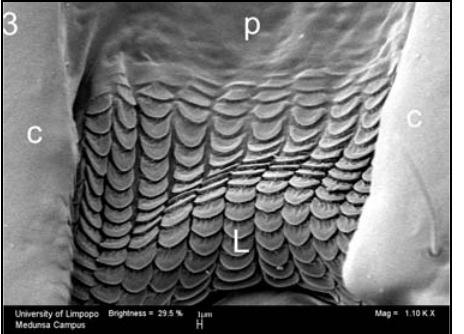
Fig. 3. An enlarged view of the labrum (L) showing the gradual structural changeover to the pulvinus (p). (c) = clypeal border.